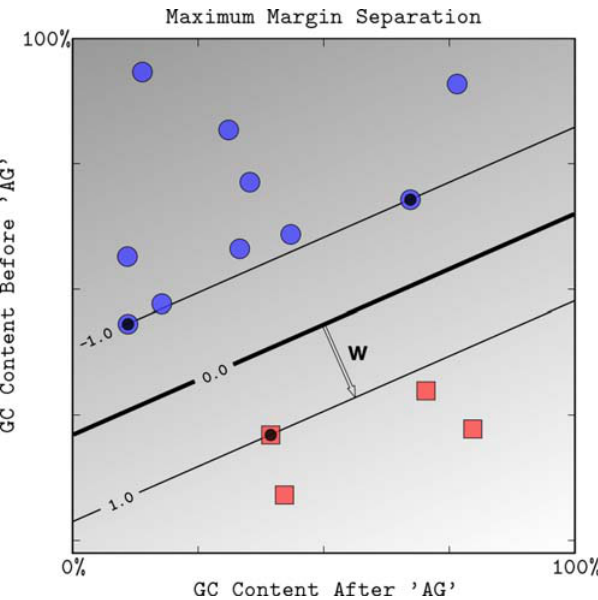
Figure 2. The maximum margin boundary computed by a linear SVM. The region between the two thin lines defines the margin area with 2 1 # Æ w , x æ+ b # 1. The data points highlighted with black centers are the support vectors : the examples that are closest to the decision boundary. They determine the margin by which the two classes are separated. Here, there are three support vectors on the edge of the margin area ( f ( x )= 2 1 or f ( x )= + 1).